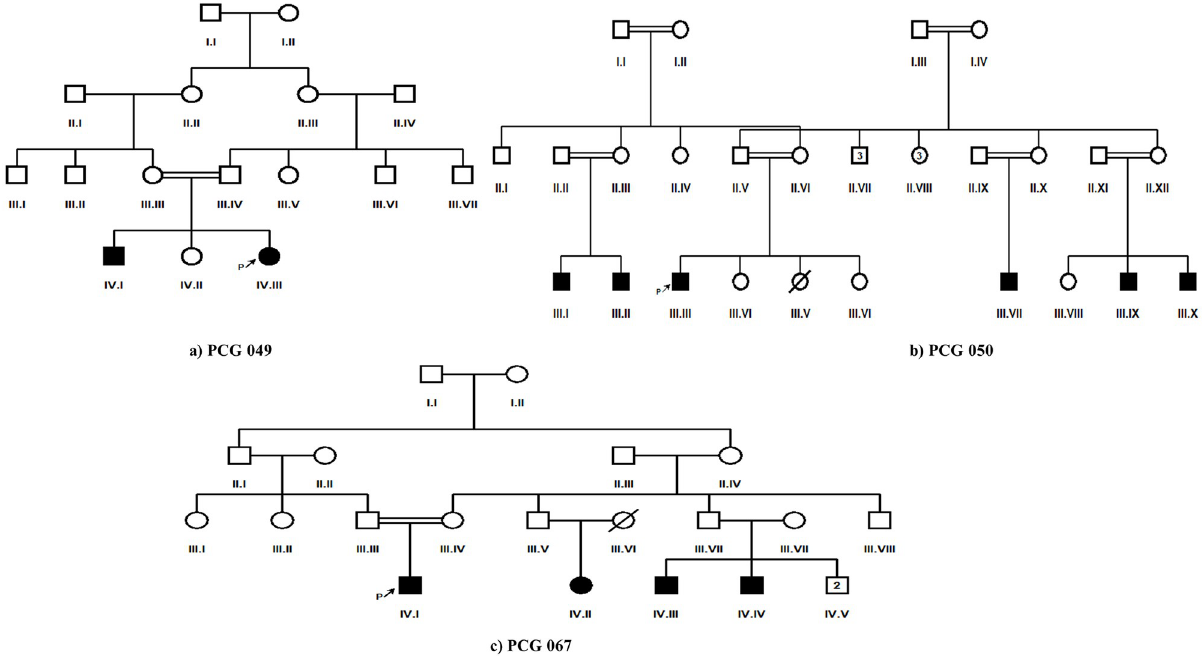
Fig 1. Pedigrees of three PCG families (PCG049, PCG050 and PCG067) having more than one affected member and segregating novel disease causing variant/s in CYP1B1 gene. Filled squares and circles indicate affected members of family. Cousin marriage is indicated by double line.